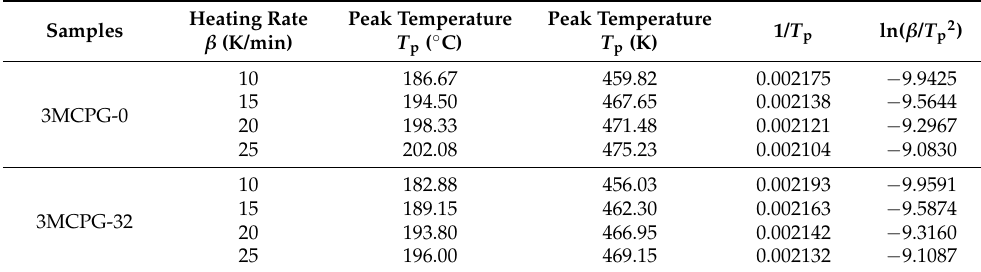
Figure 5. ( a , b ) DSC curves of ( a ) 3MCPG ‐ 0 and ( b ) 3MCPG ‐ 32 at different heating rates. ( c , d ) Kissinger equation fits for the DSC data of ( c ) 3MCPG ‐ 0 and ( d ) 3MCPG ‐ 32. Table 1. Parameters of the Kissinger equation for 3MCPG ‐ 0 and 3MCPG ‐ 32.